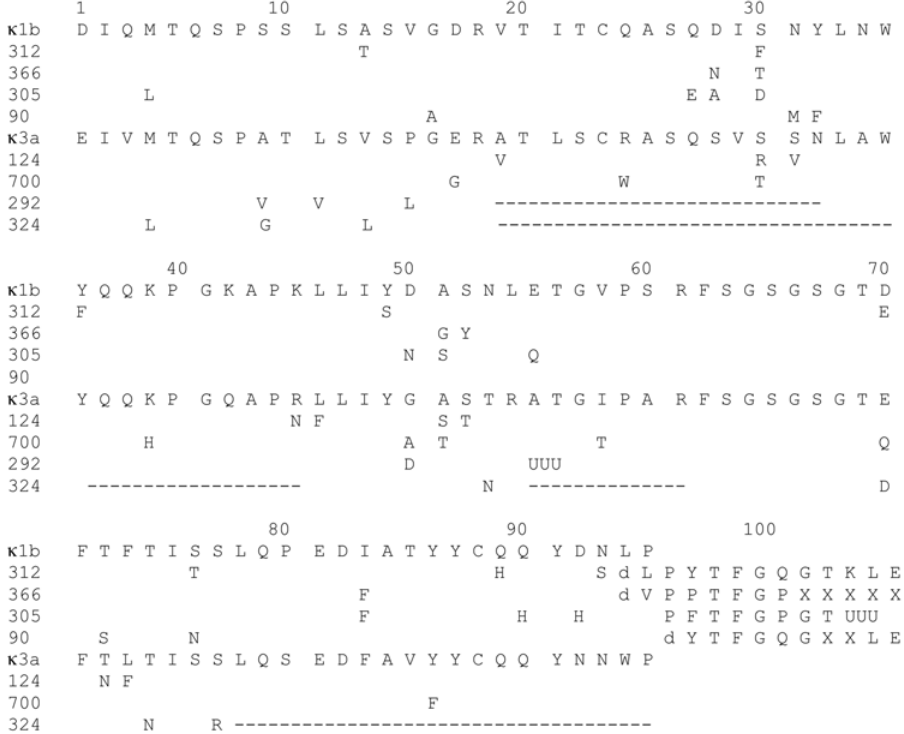
Figure 1. Primary structure of the k 1b and the k 3a light chains compared with respective germline gene sequence. ---- No sequence : d, deletion, UUU, end of the determined amino acid sequence.